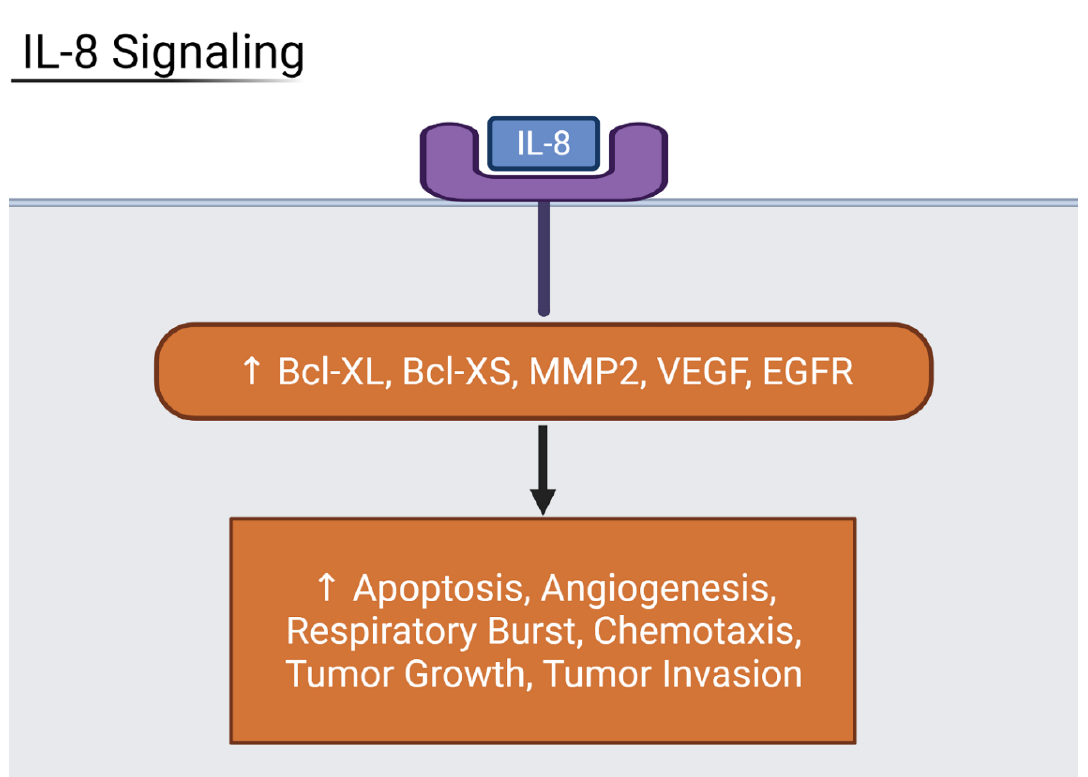
Figure 8. Diagram showing IL-8 downstream effects on organs. Inflammatory IL-8 upregulates host factors that contribute to cell death, angiogenesis, respiratory burst, and more. Generated in Biorender.